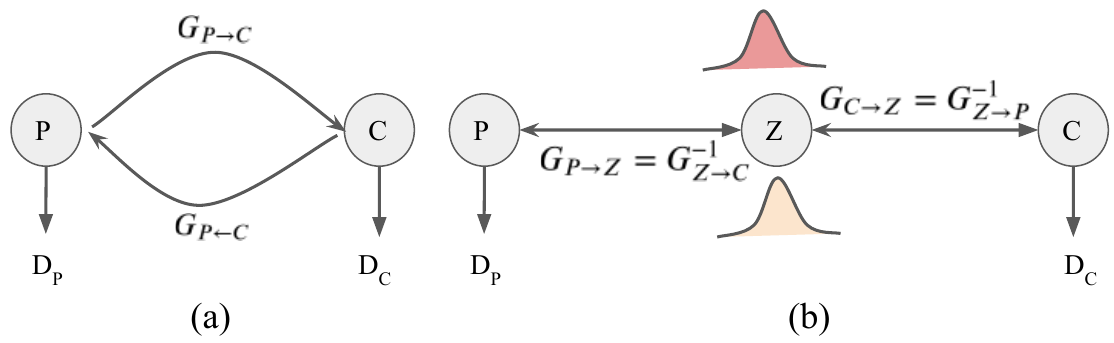
Figure 3. A comparison between ( a ) cycleGAN and ( b ) flow-based generative model. Double-headed arrows denotes invertible